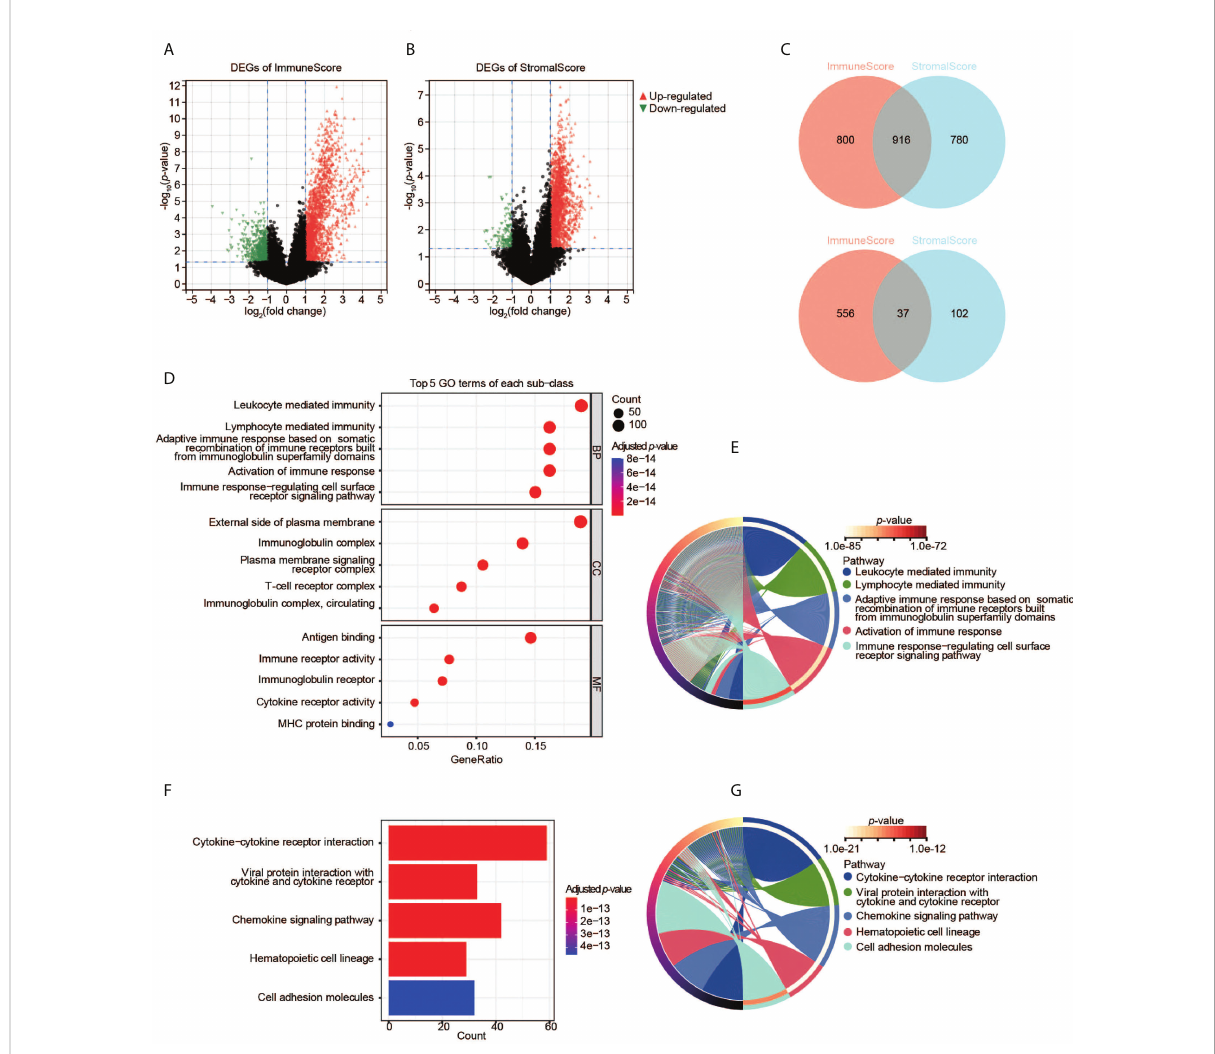
FIGURE 3 Identi fi cation and pathway enrichment analyses of DEGs. (A) DEGs based on the two groups with high and low ImmuneScore. (B) DEGs based on the two groups with high and low StromalScore. (C) Shared DEGs between the ImmuneScore and StromalScore analyses. Up-panel: upregulated DEGs; down-panel: downregulated DEGs. (D) , (E) GO enrichment analyses of DEGs. (F) , (G) KEGG enrichment analysis of